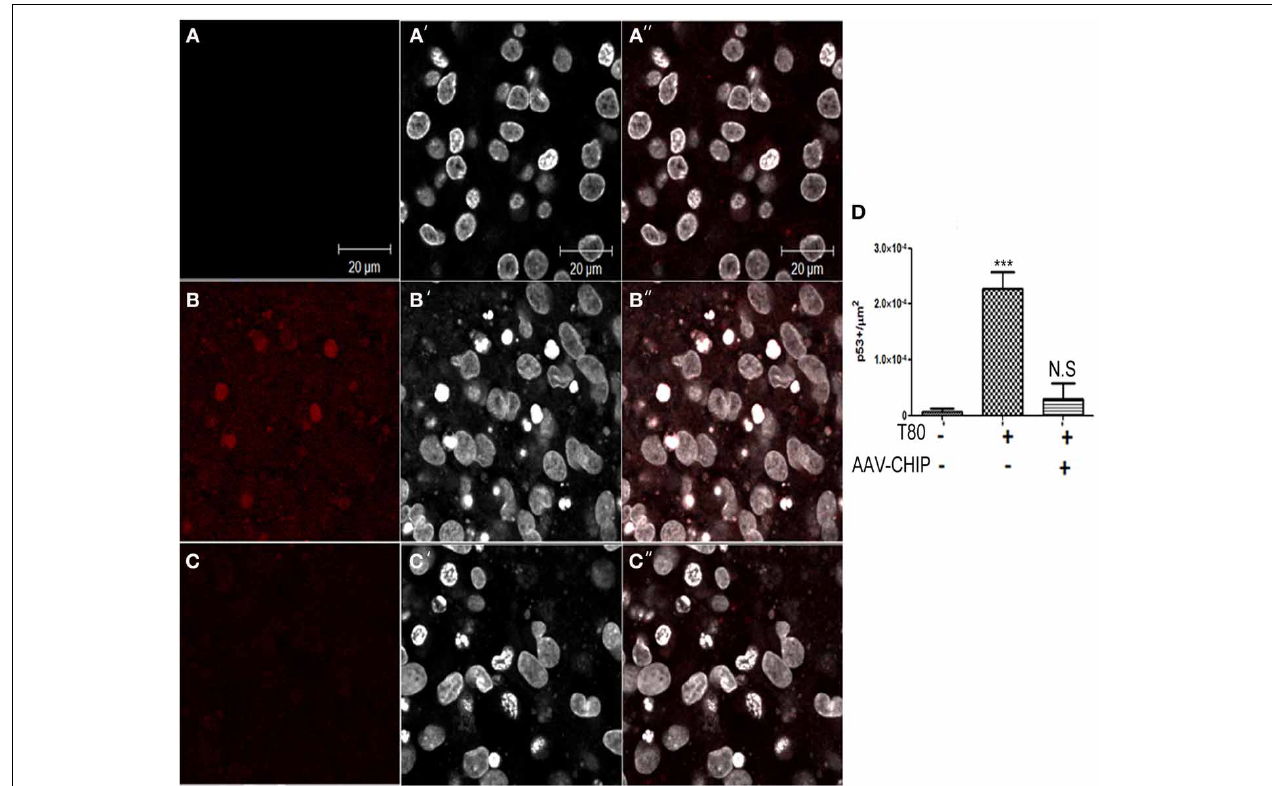
FIGURE 8 | Overexpression of CHIP diminishes p53 positive cells in hippocampal slices treated with Tunicamycin. (A–C) Immunofluorescence for p53 (in red) counterstained with nuclear marker TO-PRO3 (in white) shows increased expression in treated slices (B–B”)